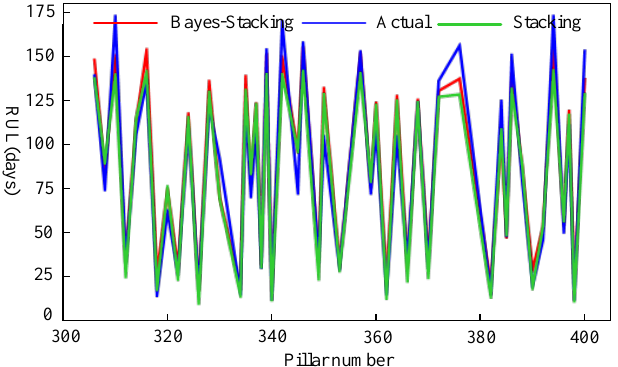
Figure 14. Before and after Bayesian hyperparameter optimization, a comparison of the model’s predicted value and the actual value was made.